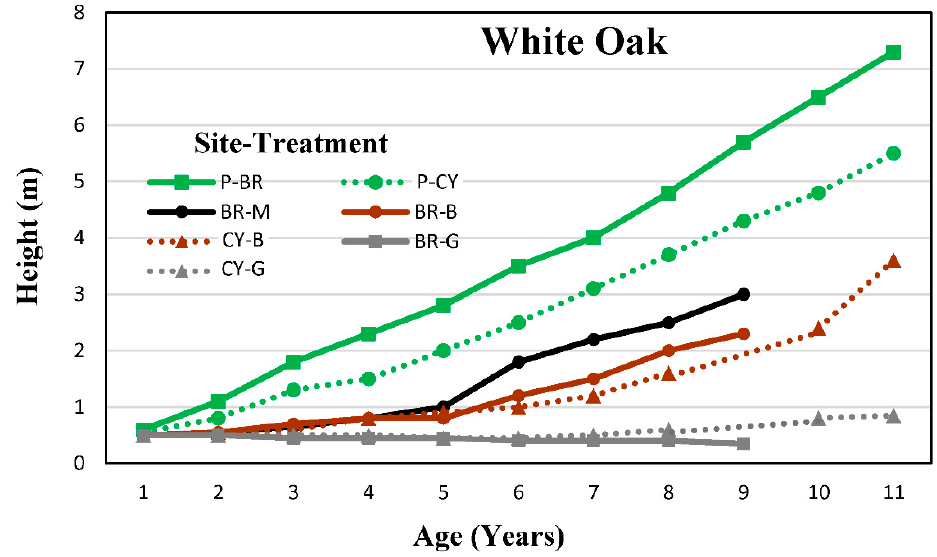
Figure 2. Height of white oak during the first 11 years of growing in pre-mine native soils (P-BR and P-CY) and in brown (BR-B and CY-B) and gray mine soils (BR-G and CY-G) at two reclaimed mine sites. White oak growth rates were 0.66 m per year in BR pre-mine native soils compared to 0.25 m per year in BR brown mine soils (about 65% less) and 0.025 m per year in gray mine soils (96% less) (Table 6). Growth rates were slightly greater for white oak on pre-mine native soils than red oak (0.66 versus 0.59 m per year; Tables 5 and 6), and the brown and gray mine soils showed similar height growth rates as red oak (0.301 ave white oak versus 0.276 ave red oak m per year for brown, respectively). Table 6. Regression equation values for white oak growing in pre-mine native soils (P-BR and P-CY) and in brown (BR-B and CY-B) and gray mine soils (BR-G and CY-G) at two reclaimed mine sites.